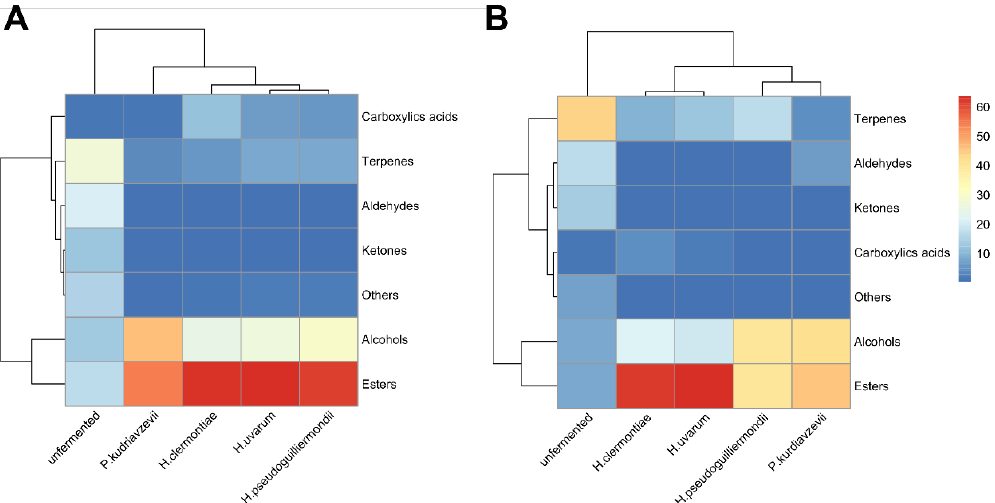
Figure 4. Heatmaps of the relative abundance (%) of volatiles organic compounds in malt wort ( A ) and malt wort added with pasteurized apricot puree ( B ) fermented by Hanseniaspora clermontiae L4 , Hanseniaspora uvarum L2 , Hanseniaspora pseudoguilliermondii L3 , and Pichia kudriavzevii L1 . Data are mean percentage of total sum area of the integrated peak area (As) compared to the area of the internal standard (AIS).